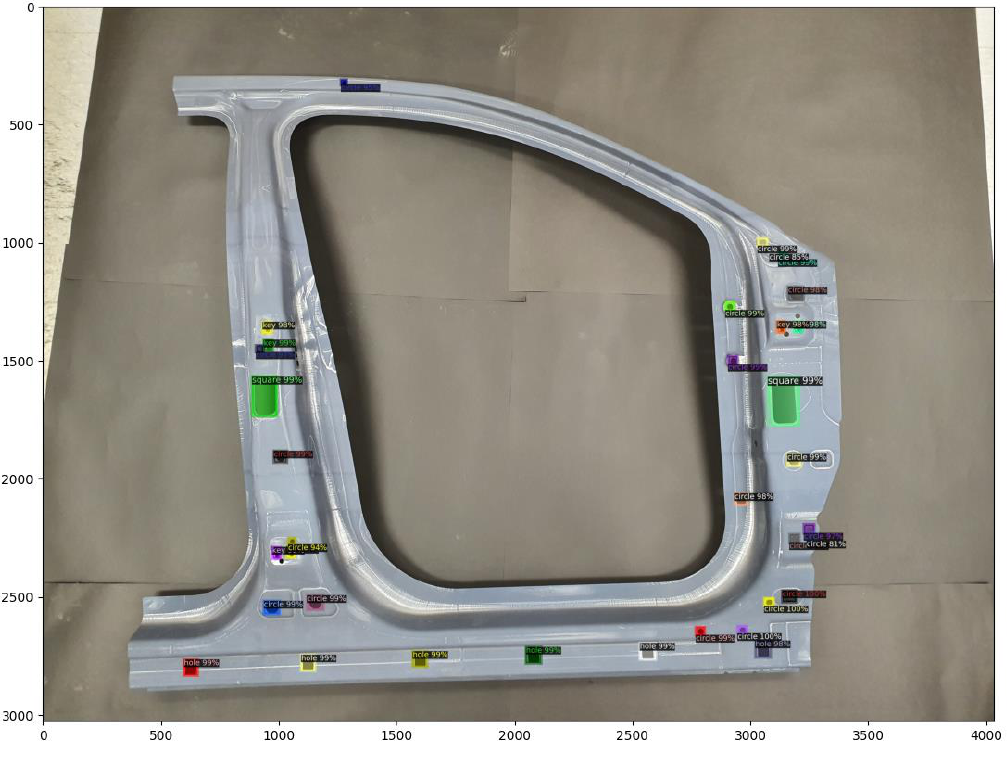
Figure 13. Bounding-box prediction result.